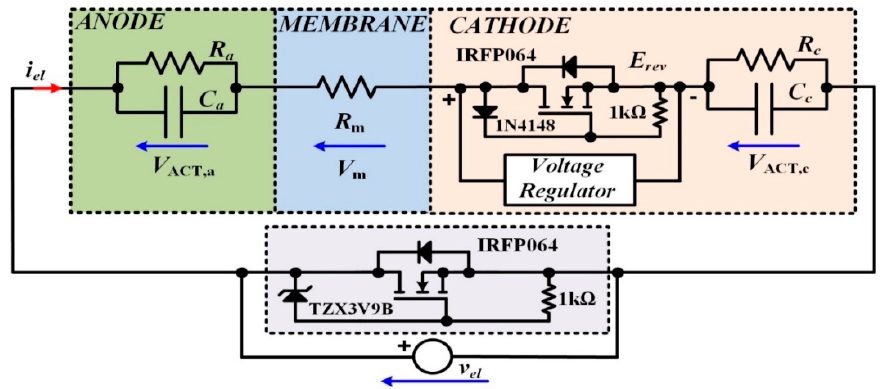
Figure 5. Principle of the voltage generator and stack voltage saturation.